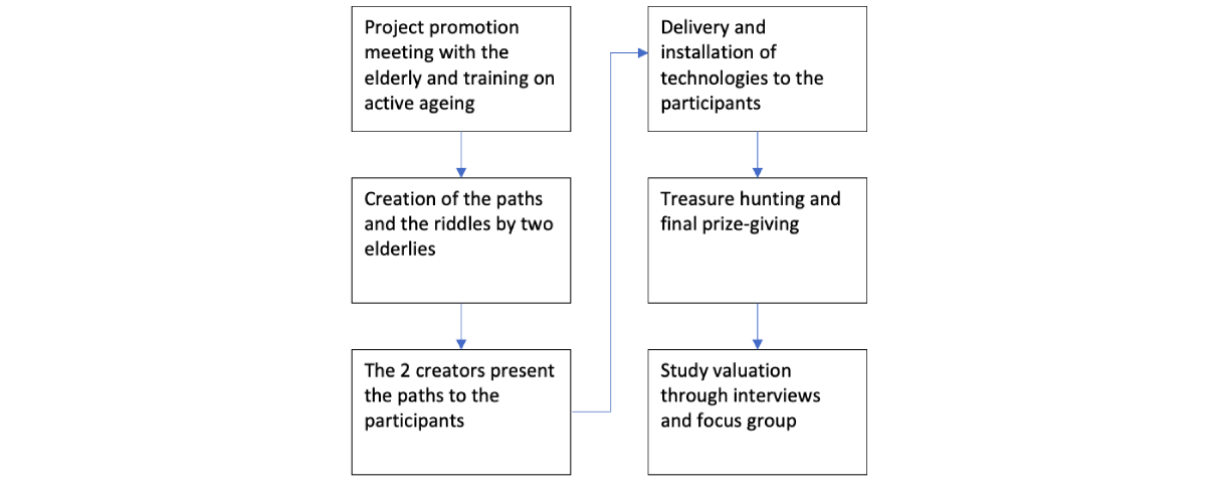
Figure 1. Flowchart of project